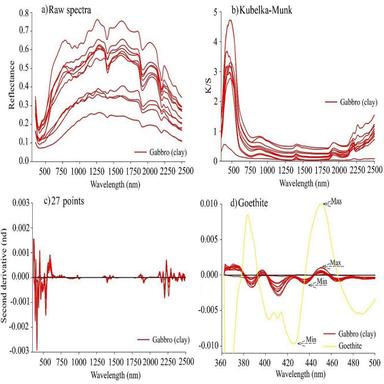
Processes performed on the raw spectra to obtain the maximum and minimum values of the spectral curve for soil samples from Brazil. (a) Raw spectra; (b) Kubelka-Munk; c) Smoothing with 27 points as window size after second derivative; d) Identification of the maximum and minimum values in preprocessed spectral curves comparing the minerals of the spectral library with the samples of the clay fraction of the soil for goethite.